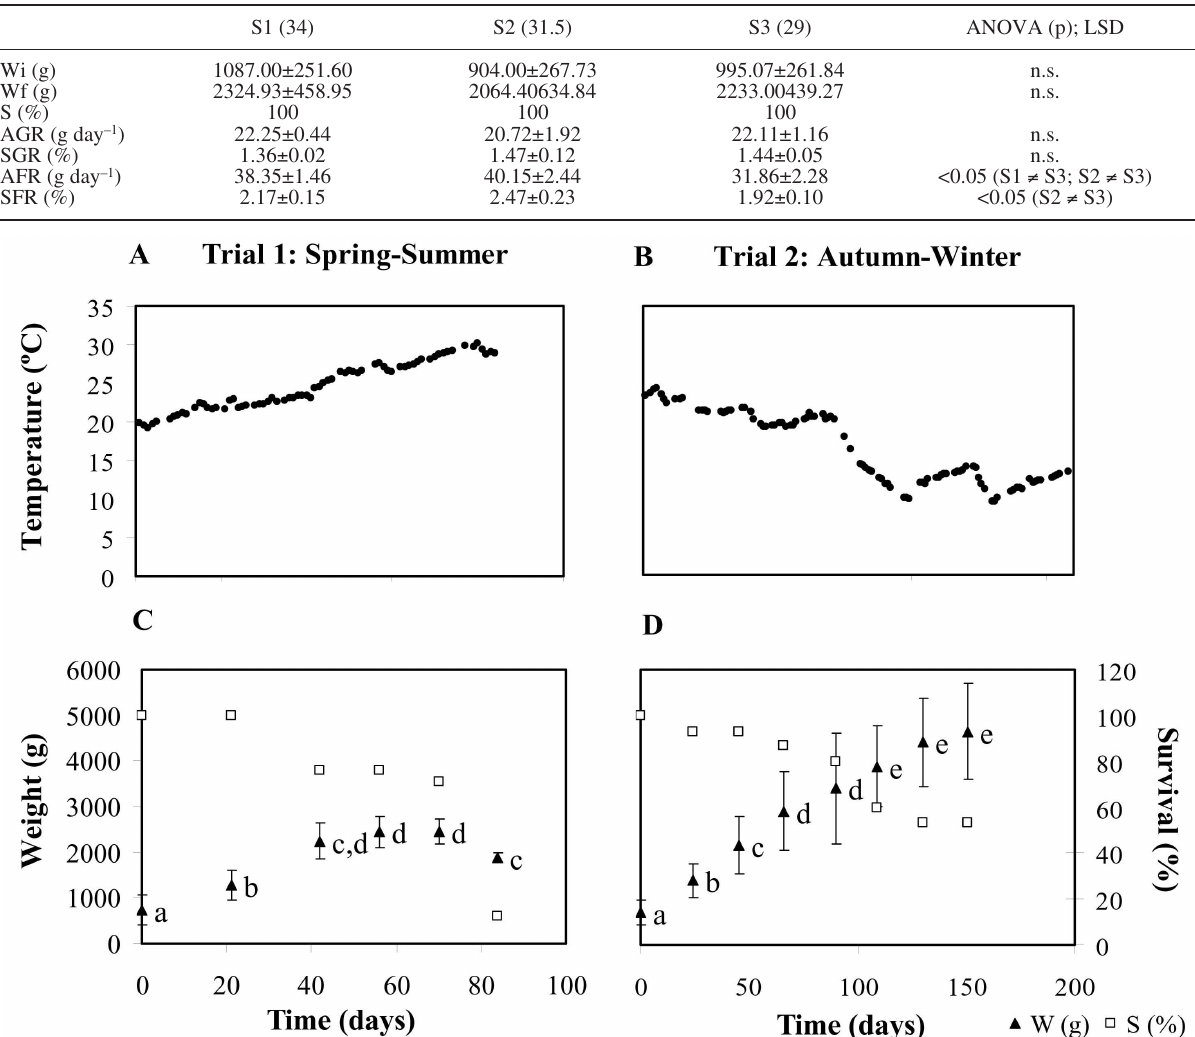
Table 1. – Mean values ± SD of every index for each experimental group in Experiment 2 (effects of salinity). Wi, initial weight; Wf, final weight; S, survival; AGR, absolute growth rate; SGR, specific growth rate; AFR, absolute feeding rate; SFR, specific feeding rate. LSD, multiple range test; n.s.= not significant.